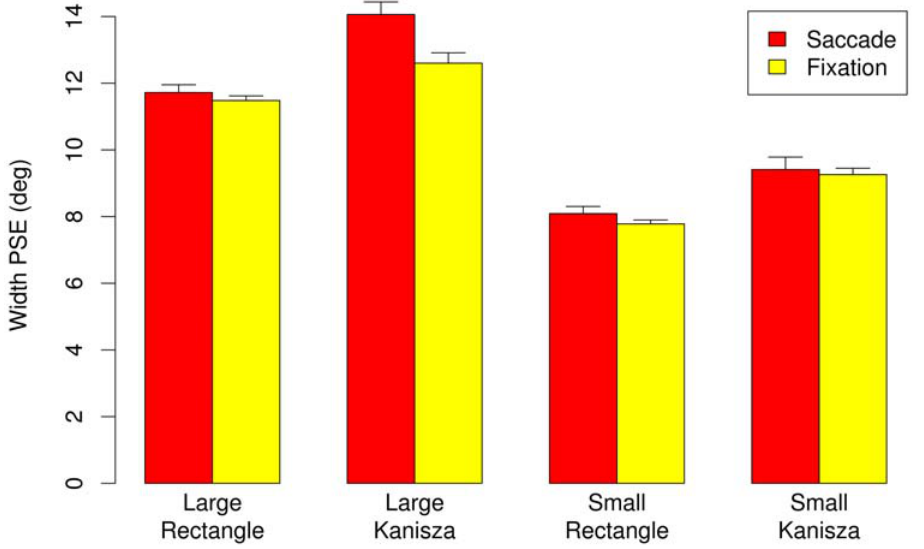
Figure 4. Experiment 1A: Perceived width (50% PSE thresholds) for the fixation and saccade conditions. Vertical bars indicate 95% within subject confidence intervals [17].